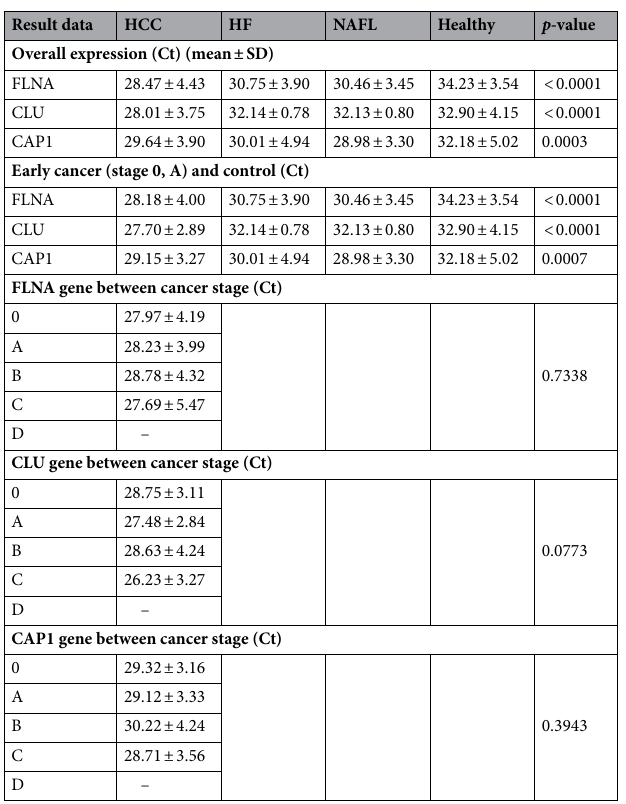
Table 3. Result data after analysis. All gene expression is result from Real time – PCR and represent by cyclic threshold (Ct) (mean ± SD) then analyzed using either ANOVA or